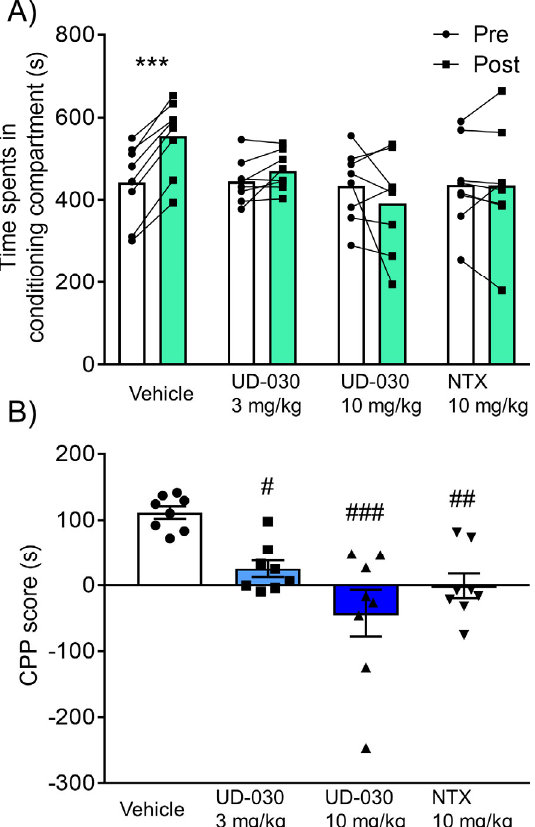
Figure 3. Inhibitory effect of UD ‐ 030 on the acquisition of morphine ‐ induced conditioned place preference. ( A ) Time spent in the drug ‐ paired compartment in the preconditioning phase (pre, white columns) and postconditioning phase (post, green columns). Mice ( n = 8/group) were pretreated with UD ‐ 030 (0, 3, and 10 mg/kg, p.o.) or NTX (10 mg/kg, p.o.) 60 min before each morphine treatment (10 mg/kg, i.p.) during the conditioning phase. Lines that connect symbols represent values for individual mice. Columns represent the mean. *** p < 0.001, difference between pre ‐ and postconditioning phases for each treatment. ( B ) Conditioned place preference (CPP) scores for each treatment of mice. The columns and vertical lines represent the mean ± SEM. # p < 0.05, ## p < 0.01, ### p < 0.001, compared with vehicle ‐ pretreated (control) mice.